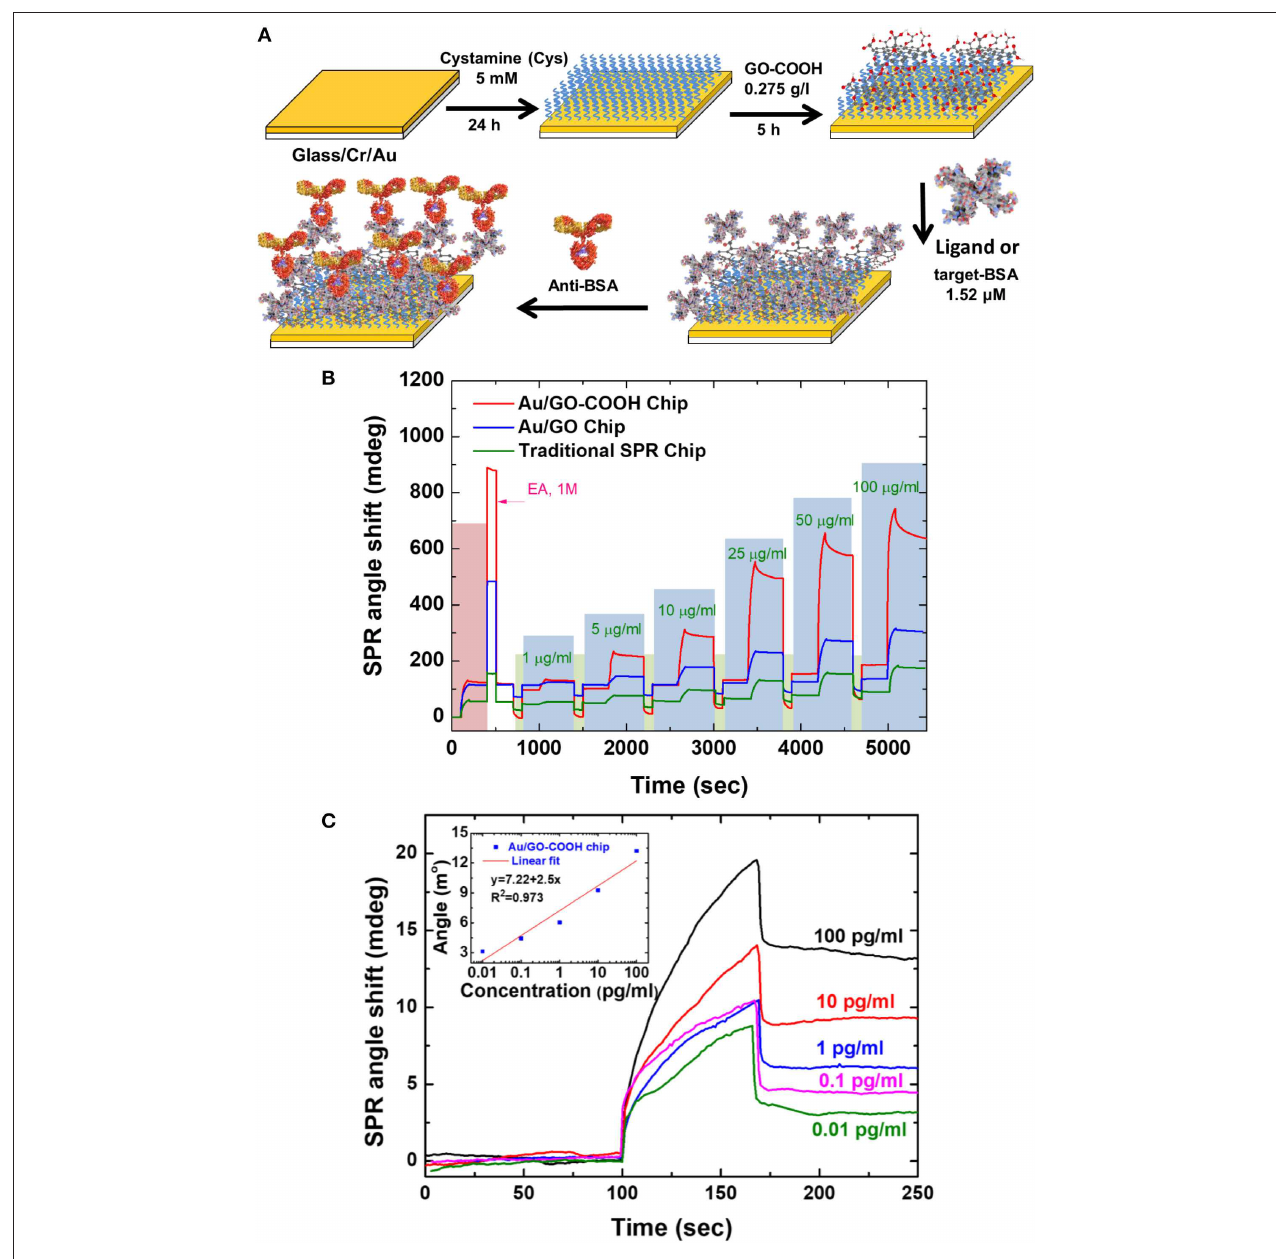
FIGURE 5 | (A) Fabrication of SPR chip with biomolecular immobilization on modified surface of carboxyl-functionalized GO film. (B) Analysis of antigen-antibody interaction on various sensing chips with various analyte concentrations. (C) Sensogram and calibration curve on Au/GO-COOH chip at concentrations of 0.01–100 pg/mL. Figures (A–C) were reproduced from Chiu et al. (2017a) with permission from Elsevier. Copyright 2017, Springer